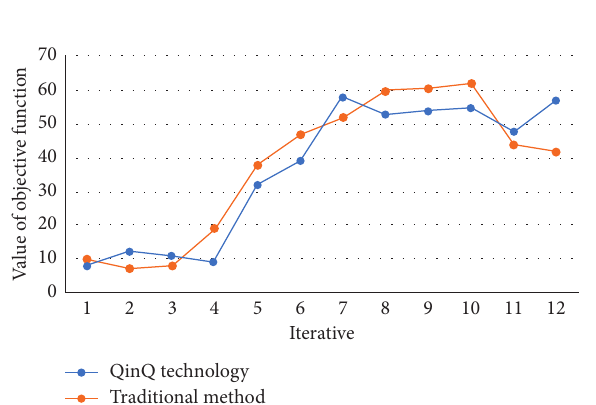
Figure 5: Change of target value with iteration times.